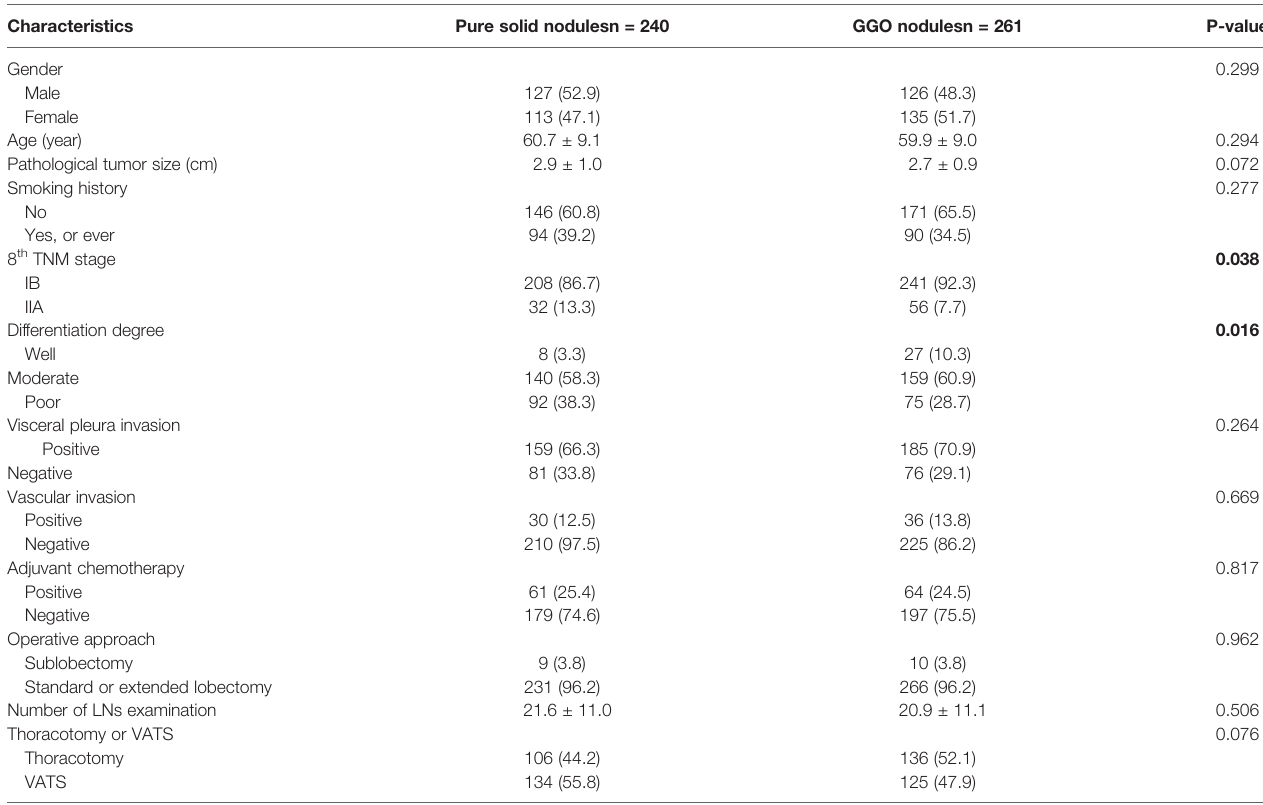
TABLE 1 | Patient ’ s